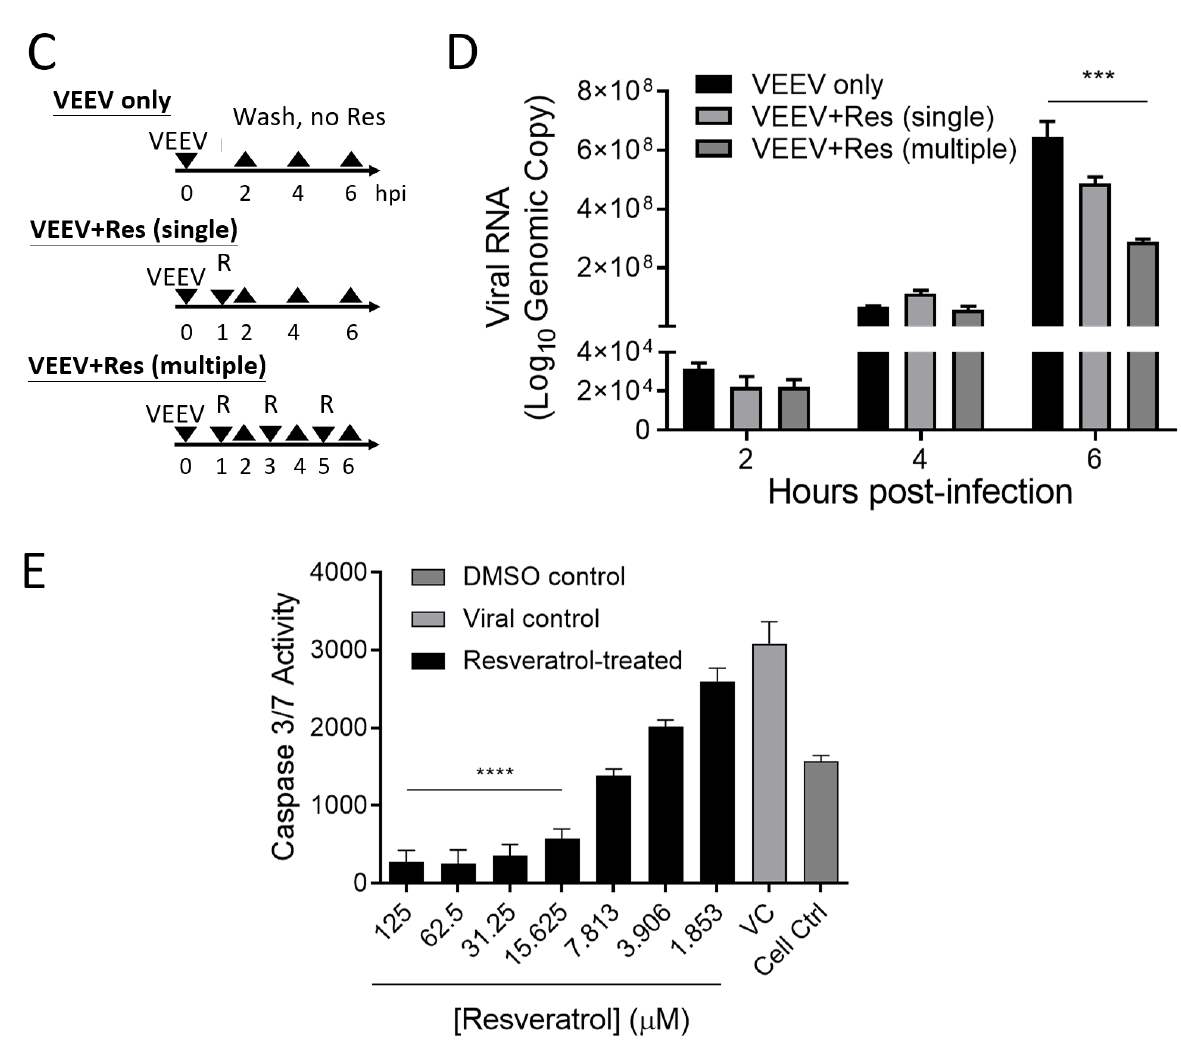
Figure 3. Time of addition of resveratrol marginally changed is antiviral effectiveness. ( A , C ) Schematic diagrams illustrating the experimental design for the time-of-addition experiments. ( B ) Luciferase activity and ( D ) viral RNA of VEEV-TC83luc at an MOI of 0.1 corresponding to the experimental designs were determined by BrightGlo ® assays and qPCR, respectively, at 16 h.p.i. ( E ) Apoptotic signaling activity of caspase-3 and caspase-7 in VEEV-infected Vero cells (MOI = 0.1) were measured with Promega’s Caspase-3/7-Glo ® assays at 16 h.p.i. *** p < 0.001; **** p < 0.0001 by one-way ANOVA. Data are represented as means ± S.E.M. VC, viral control.